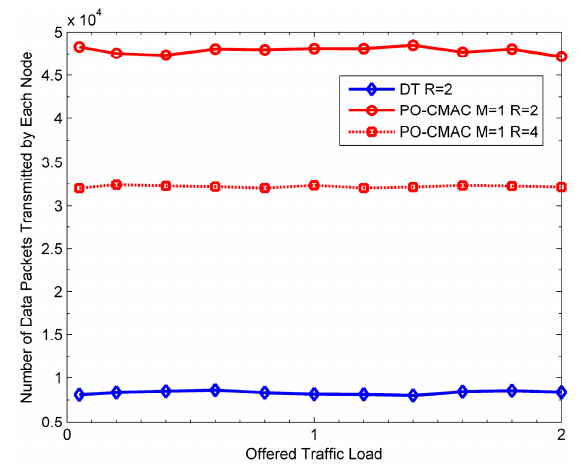
Figure 21. Number of data packets transmitted by each node vs. offered traffic load.